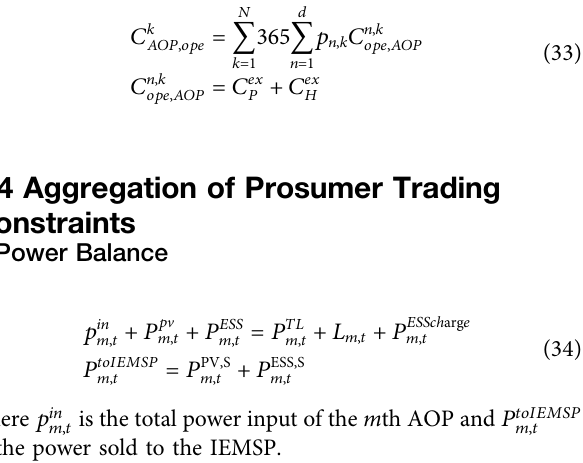
Algorithm 1. IEMSP-AOPs non-cooperative capacity